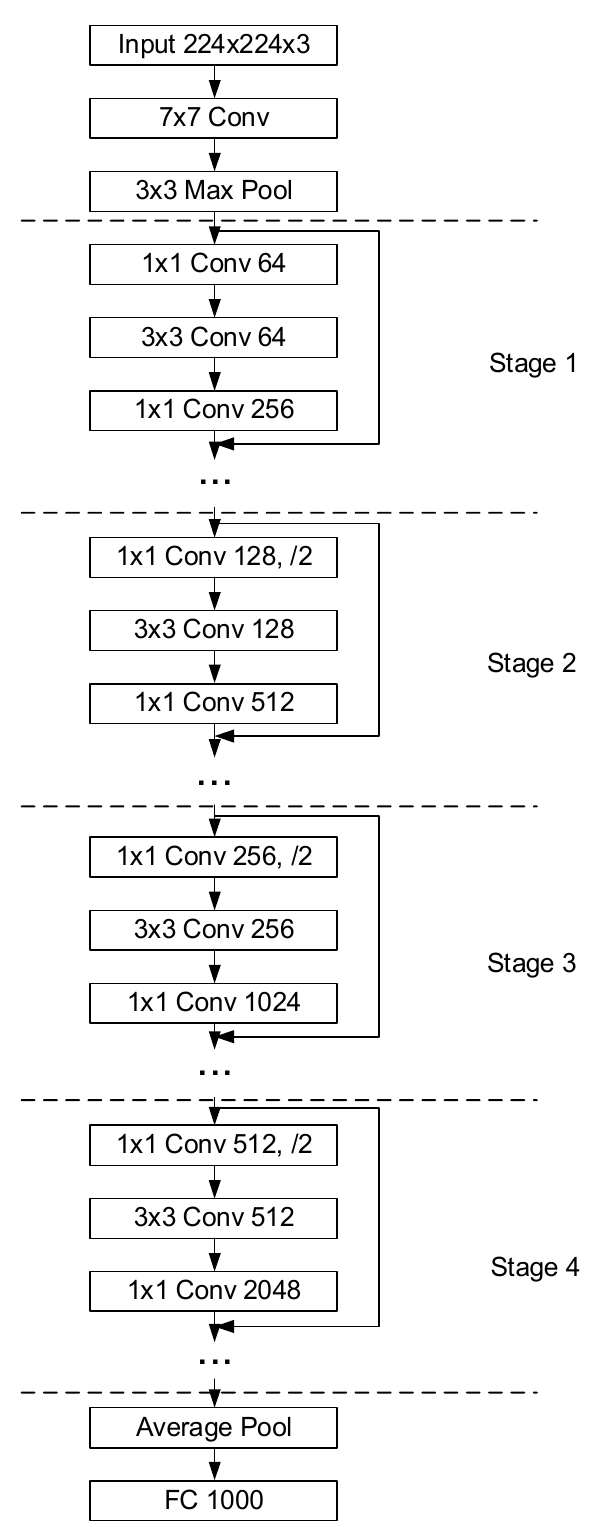
Figure 5. Architecture of ResNet50.